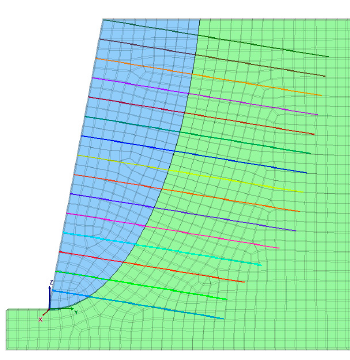
Figure 1. Sketch of the rock slope.